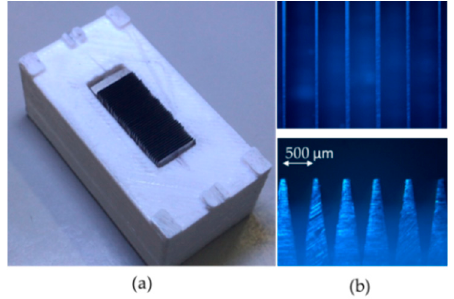
Figure 2. ( a ) Laminated plate construction, ( b ) top and lateral view (4X).